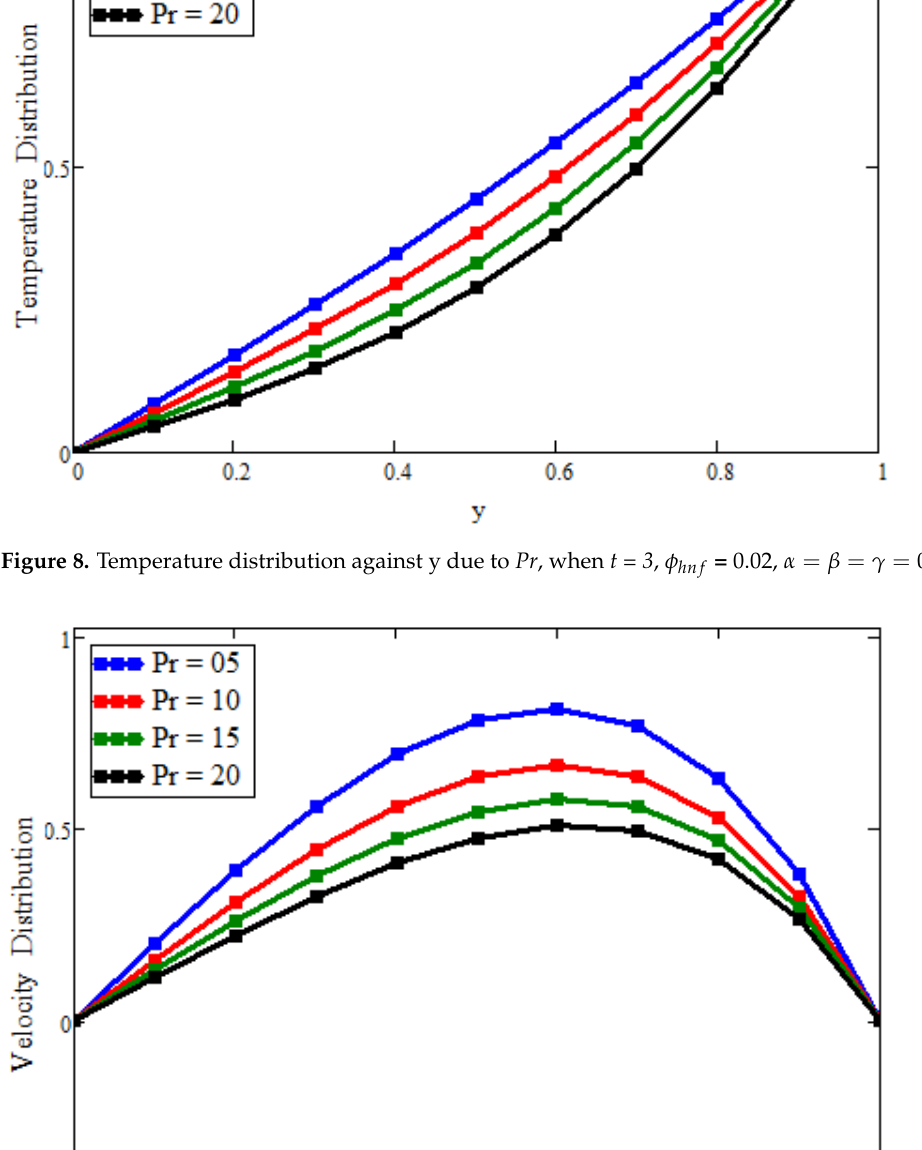
Figure 9. Velocity distribution against y due to Pr, when t = 3, 𝜙 (cid:3035)(cid:3041)(cid:3033) = 0.04, Gr = 15, M = 0.1, 𝛼 = 𝛽 = 𝛾 = 0.5 .